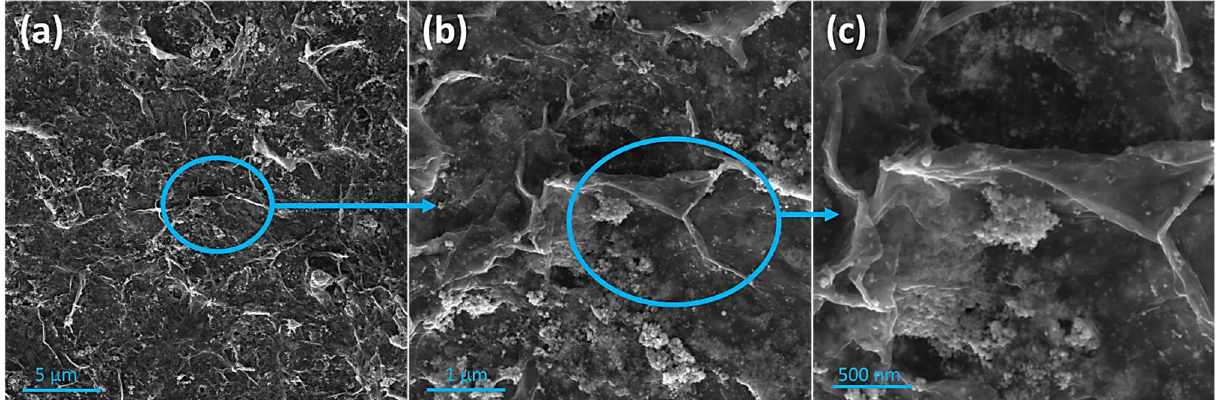
Figure 2. SEM images of the multi-layered porous structure of the CeO 2 -Pd-PDA/rGO heterojunction nanocomposite with wrinkles and open edges at different magnifications. Scale bar: ( a ) 5 µm, ( b ) 1 µm, and ( c ) 500 nm.